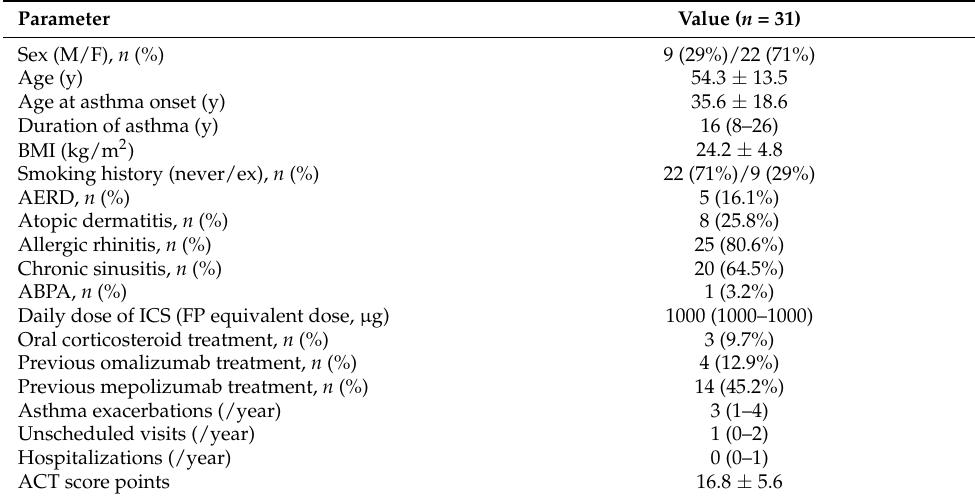
Table 1. Baseline characteristics of the study population.